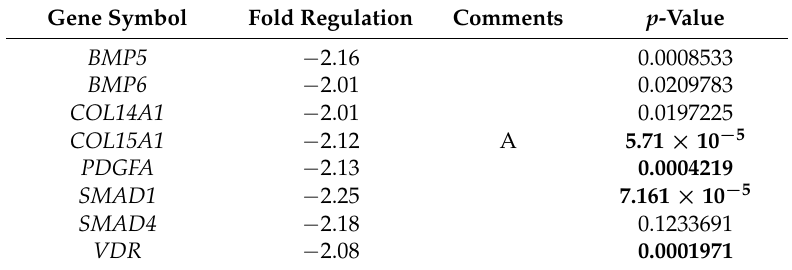
Figure 4. Volcano Plot for changes of gene expression in MG63 cells after 24 h incubation with Co/Cr particles vs. unstimulated control. Expression data are normalized to GAPDH. The statistical significance is plotted versus fold-change on the y - and x -axes, respectively. The horizontal line represents the significance level ( p = 0.0006). Up-regulated genes are depicted in red, down-regulated genes in green and genes regulated by less than factor 2 in black. Data are summarized from four independent experiments. Table 3. Genes down-regulated after 24 h of stimulation with particles by at least a factor of 2 (normalization of C t -values to GAPDH). The significance level was adjusted for multiple testing to 0.0006 (bold p -values are significant), A = in either the control or the test sample, the average C t is high (>30 cycles).